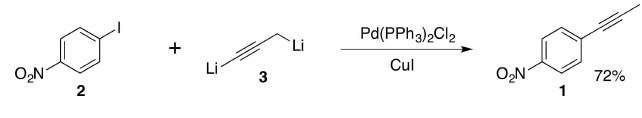
Figure 2 The crystal packing of the title